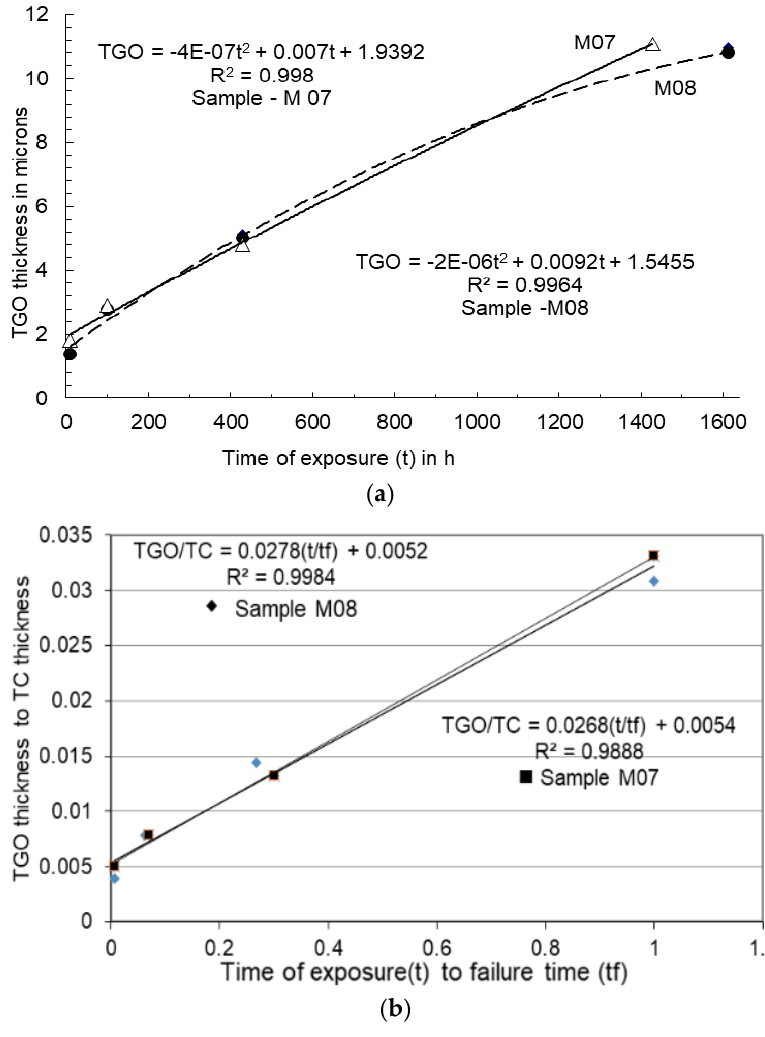
Figure 6. ( a ) Nonlinearity trend for TGO thickness vs. time of exposure fitted with 2-degree polynomials; ( b ) linearity trend with parameterized data for TGO thickness and thermal exposure for both samples, M07 and M08 [32]. Sample designations refer to oxidation under low-oxygen partial pressure (pressure of about 0.27 Pa) and atmospheric-pressure conditions respectively.